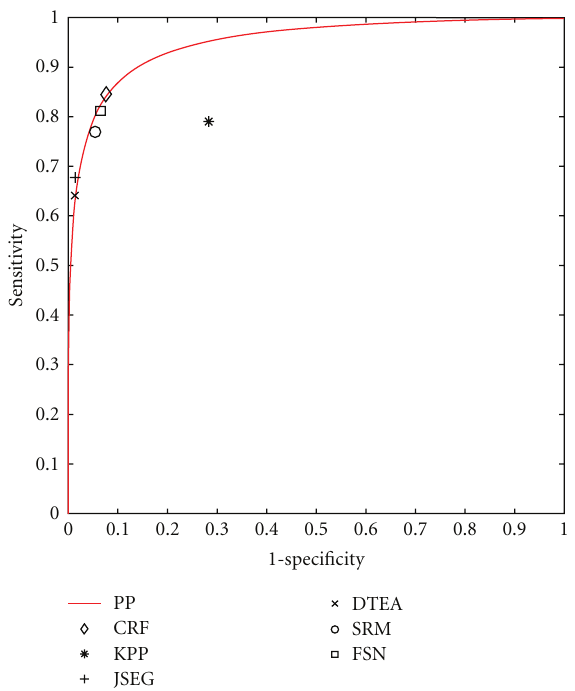
Figure 9: ROC curve comparing our CRF model (diamond) to our PP model (line) and 5 previously published